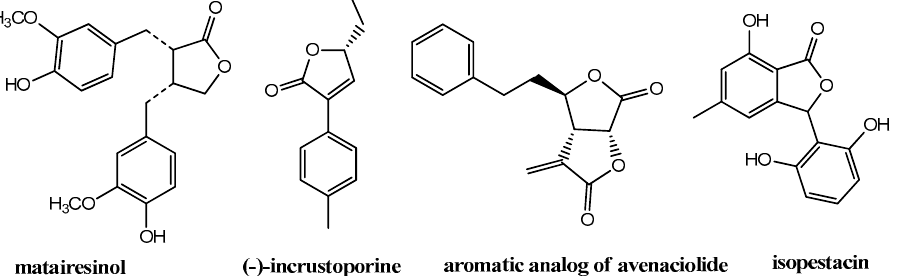
Figure 1. Lactones with aromatic rings exhibiting antimicrobial activity.